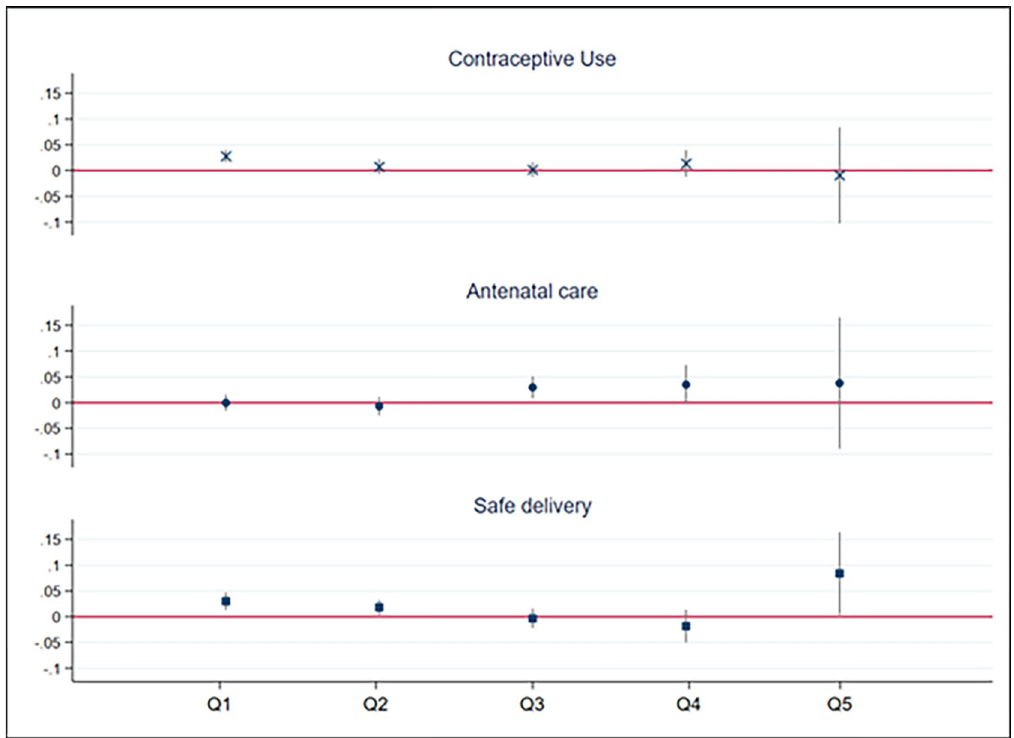
Fig 2. Mobile phone ownership marginal effects on reproductive health by wealth